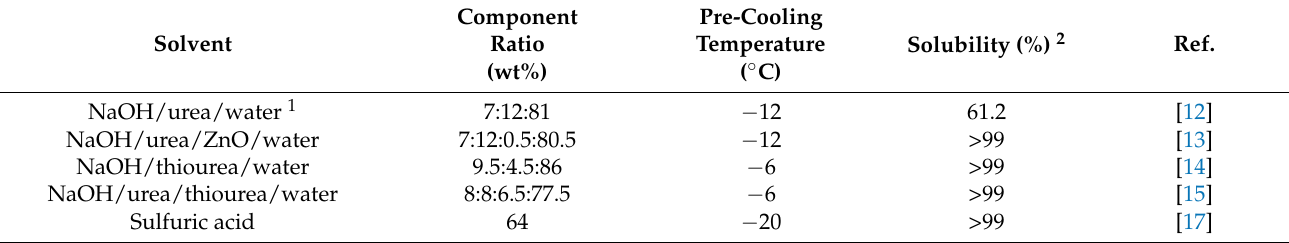
Table 2. The components of cellulose